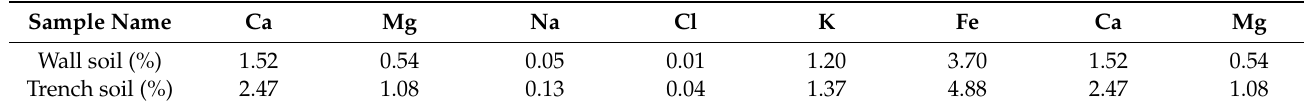
Table 4. Salt composition of soil